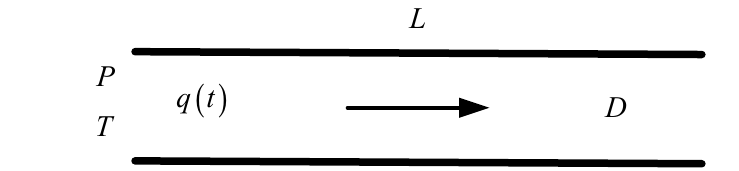
Figure 4. Simplified physical model of gas pipeline.